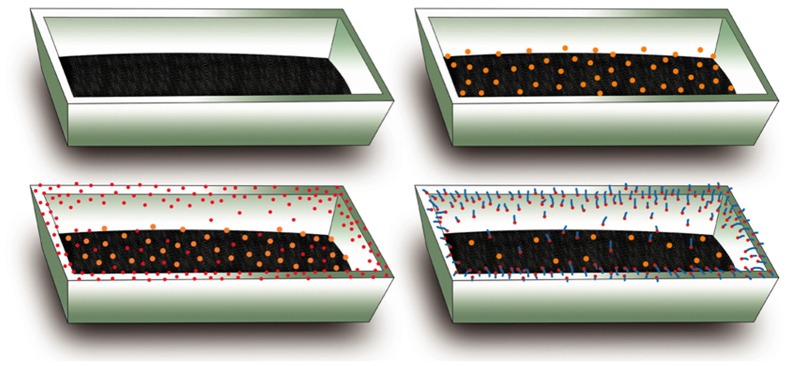
A schematic illustration for the growth process of Si3N4 NWs.